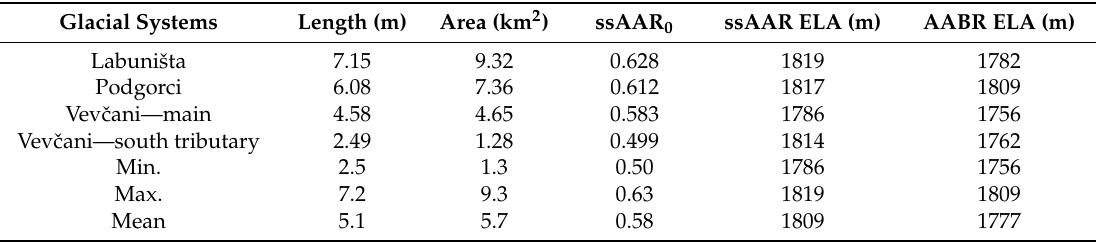
Table 2. Results from the glacial reconstruction of the Vev č ani phase (reconstructed maximum ice extent (rMIE)) on Jablanica Mt.